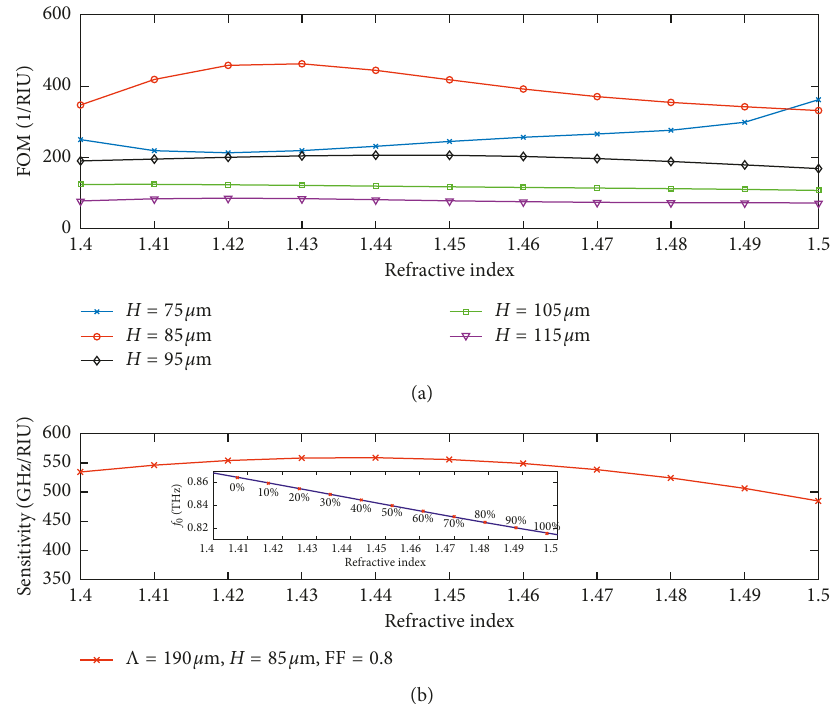
Figure 5: (a) FOM as a function of refractive index with a variation of H in an Au-coated PDMS grating with Λ � 190 μ m, FF � 0.8, and t m � 100nm at the incident angle of 10 ° . (b) Sensitivity plot of the interested refractive range, 1.4 to 1.5, of the optimized grating structure with Λ � 190 μ m, FF � 0.8, H � 85 μ m, and t m � 100nm at the incident angle of 10 ° . The inset shows the resonance frequency f 0 of this grating for different compositions of gasoline-toluene mixture.